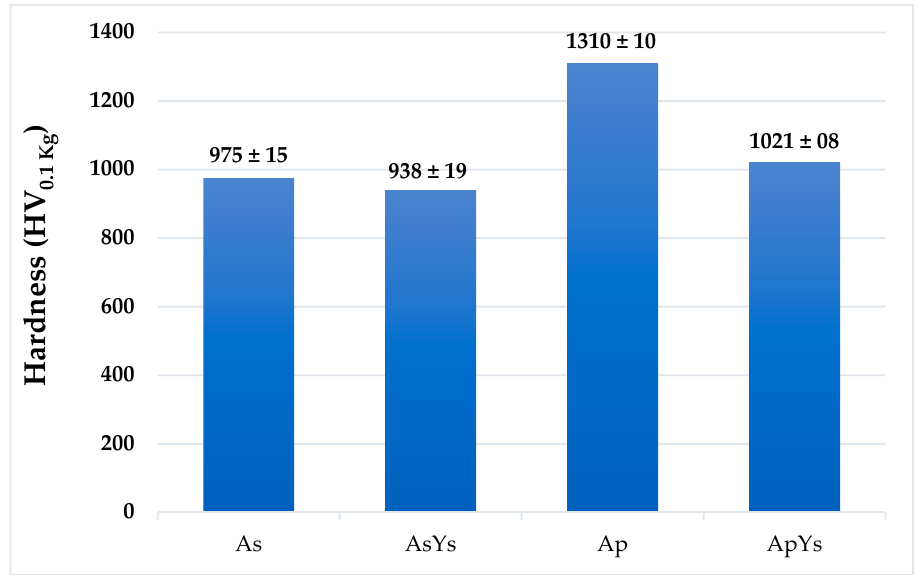
Figure 7. Vickers microhardness values of the coatings As, AsYs, Ap, and ApYs.